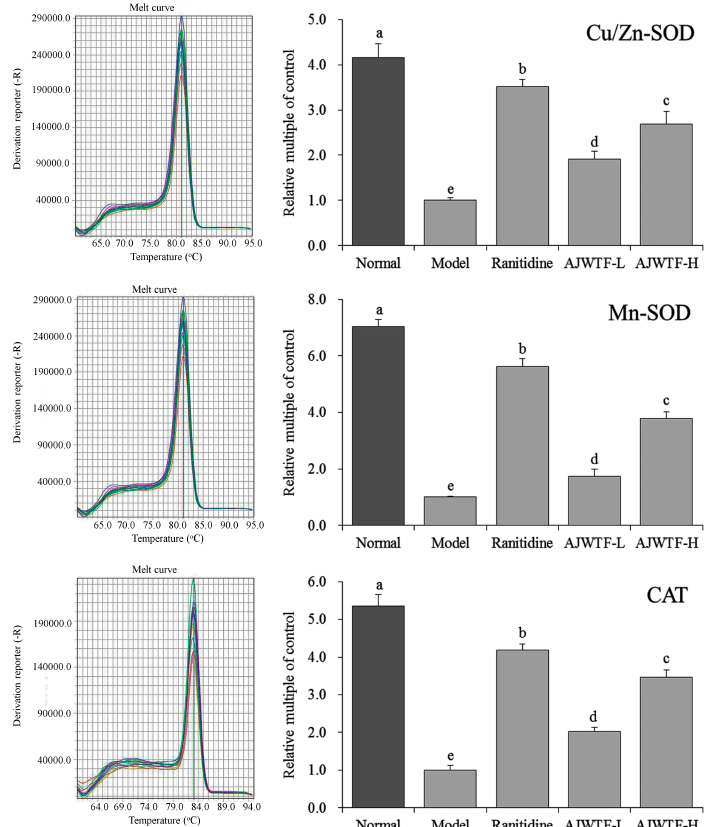
Figure 4. Messenger RNA expression of copper/zinc superoxide dismutase (Cu/Zn–SOD), manganese SOD (Mn–SOD), and catalase (CAT) in the stomach tissues of mice from each group. Values presented are the means ± standard deviation. a–c Mean values with different letters in the same bars indicate significant difference ( p < 0.05) according to Duncan’s multiple-range test. Ranitidine: Ranitidine at 50 mg/kg body weight (b.w.) by gavage; AJWTF-L: Anji white tea flavonoids at 100 mg/kg b.w. by gavage; and AJWTF-H: Anji white tea flavonoids at 200 mg/kg b.w. by gavage.